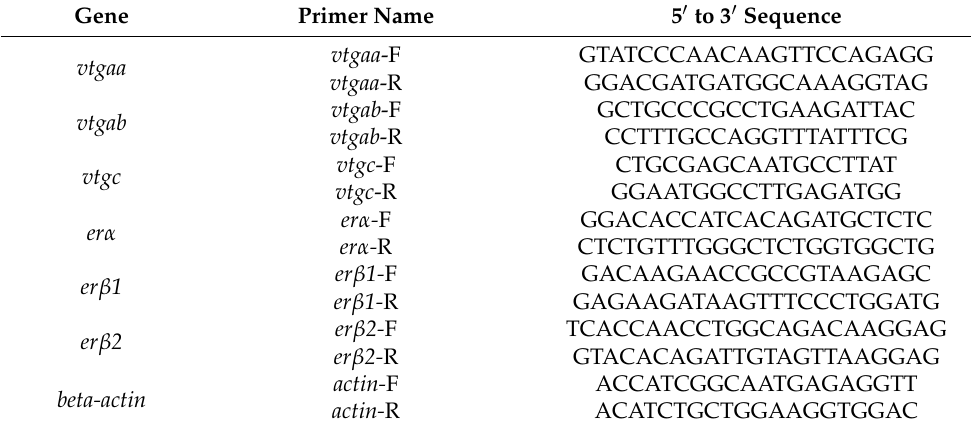
Table 2. Primers used for Real-Time PCR.